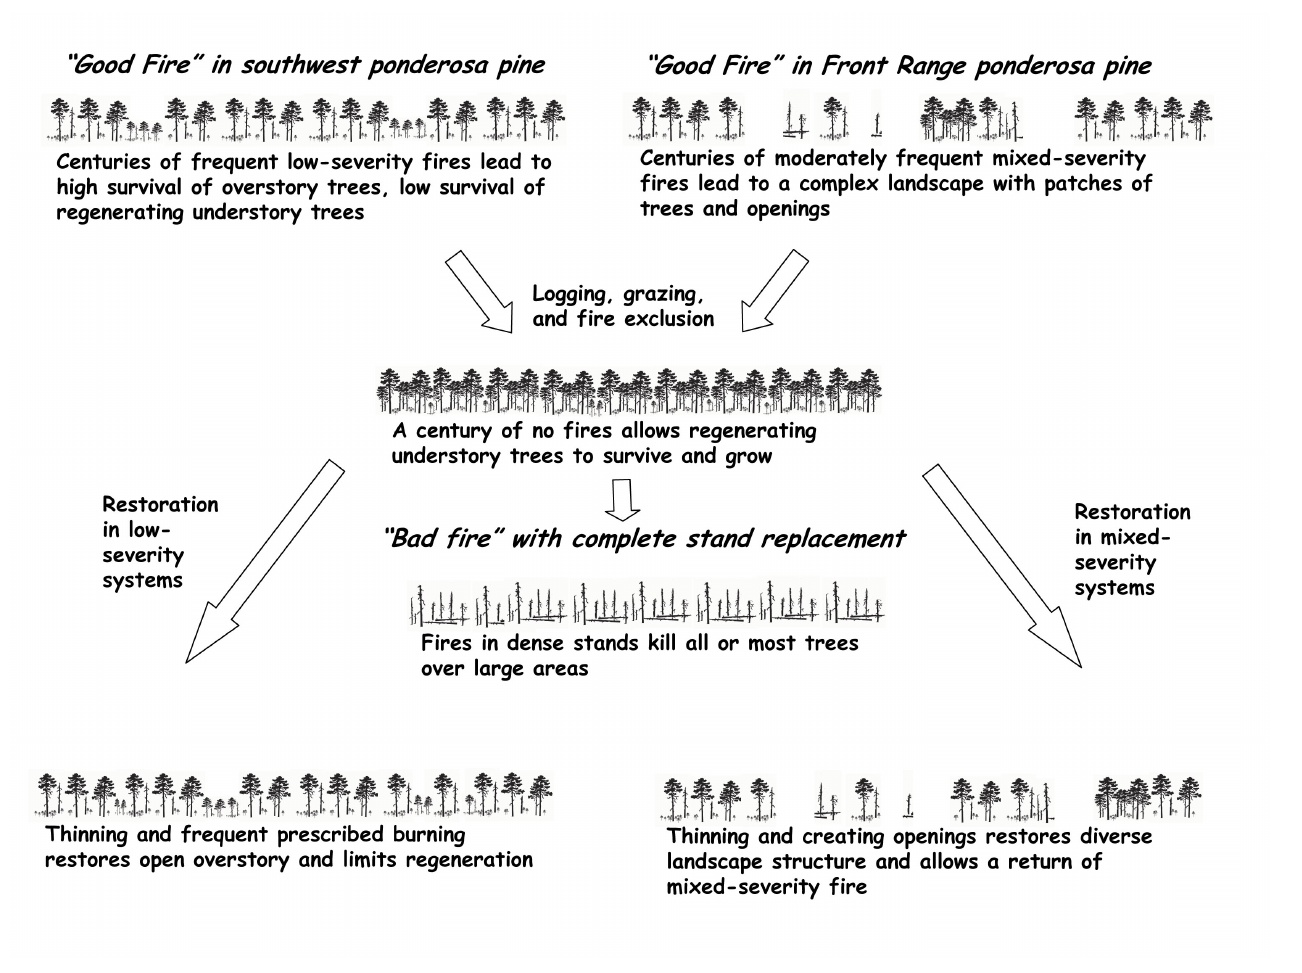
Fig. 1. Comparison of historical, current, and restored ponderosa pine landscapes in the Southwest (left) and Colorado Front Range